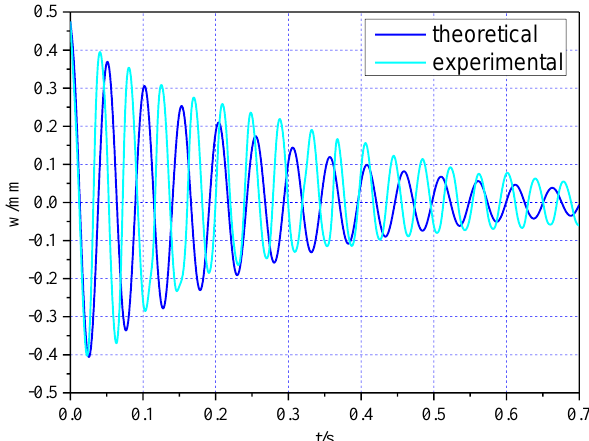
Figure 9. Comparison of two time-displacement curves under initial displacement 0.475 mm.